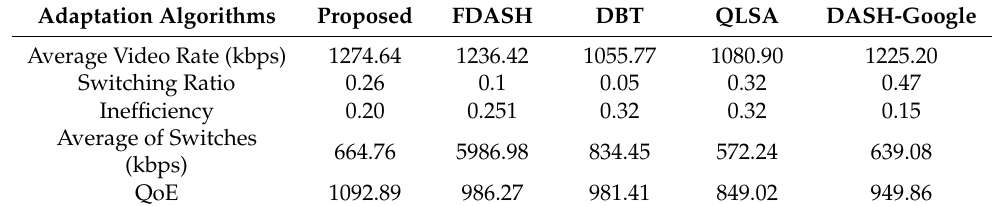
Table 6. Performance of algorithms at a buffer size of 60 s and a segment duration of 4 s.